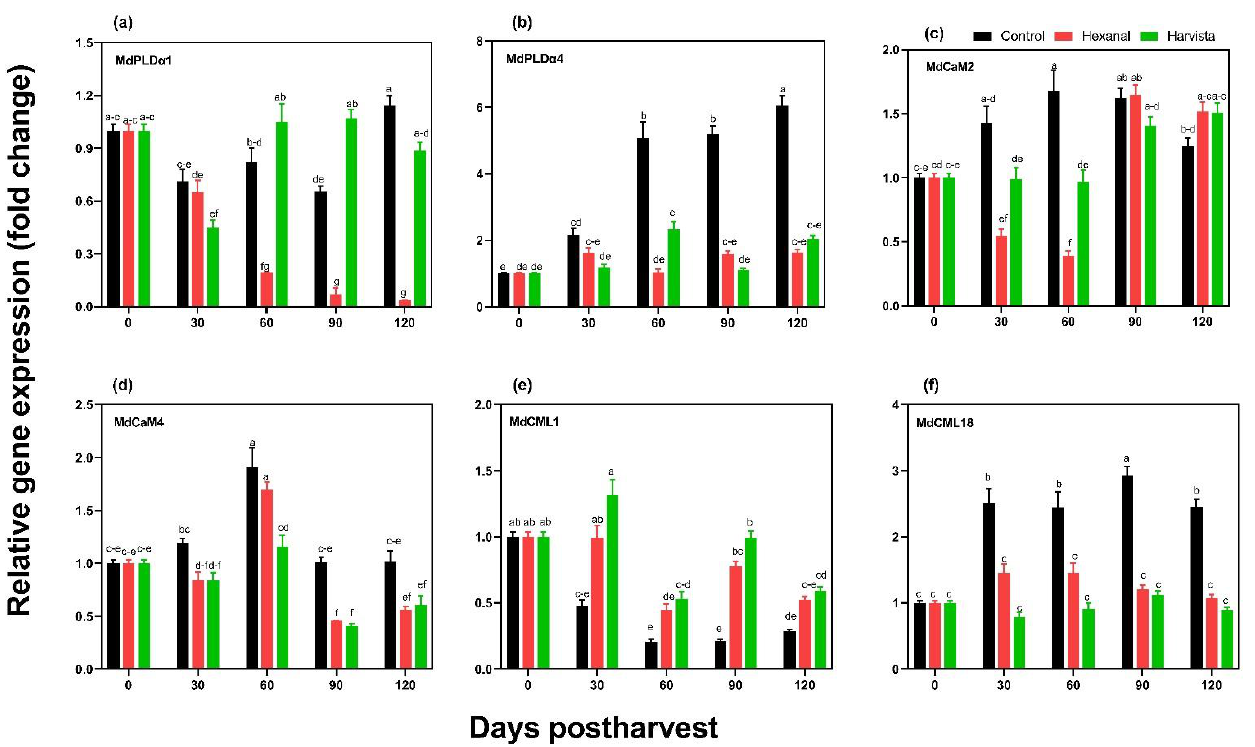
Figure 4. Effects of preharvest sprays hexanal and Harvista TM on gene expression of two αPLD genes ( a , b ) and four calmodulin genes ( c – f ) in ‘Honeycrisp’ apple throughout 120 days postharvest. Transcript levels at all storage time points were expressed relative to their transcript level at 0 days postharvest. Each value represents the mean ± SE of three apples, with three replicates normalized against the housekeeping genes MdAct and MdHis3 . Means with the different letters at the same storage time indicate significant differences among control, hexanal and Harvista TM treatments based on the Tukey-Kramer test at α = 0.01.